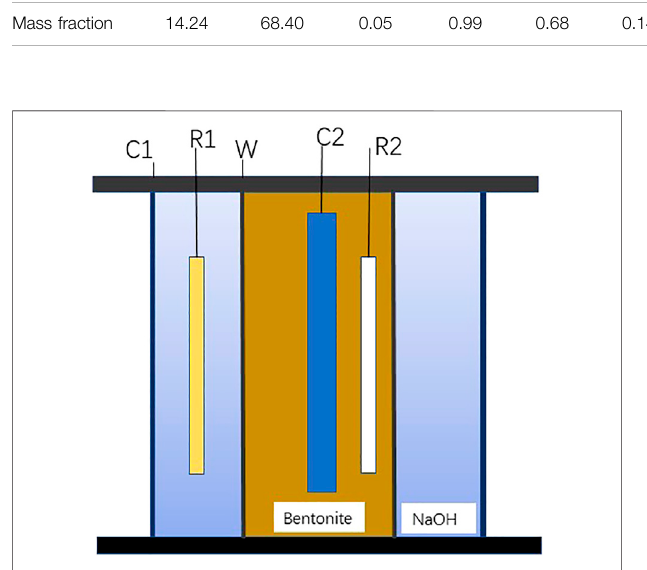
FIGURE 3 | Double electrolytic cell device for hydrogen permeation test of Q235 steel in saturated compacted bentonite.